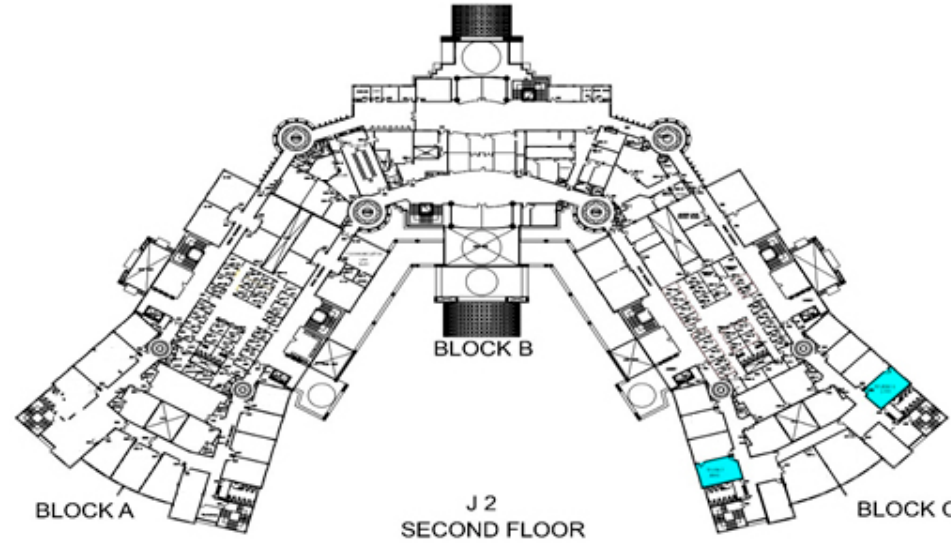
Figure 2. The target classrooms in the J2 Building at Ajman University.